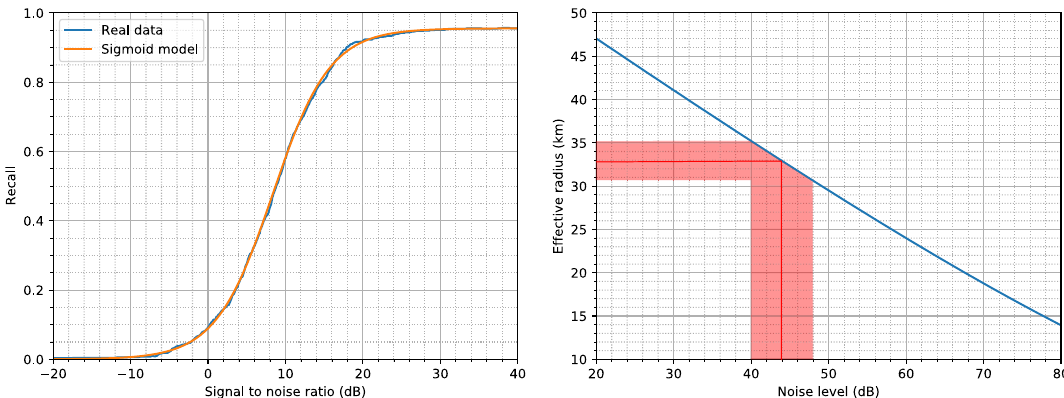
Figure 7. Left: recall of the CNN and the sigmoid model of this recall curve. Right: effective radius of the antenna for varying background noise level. The red line (zone) corresponds to the average (standard deviation) noise level at 12.8 kHz in the